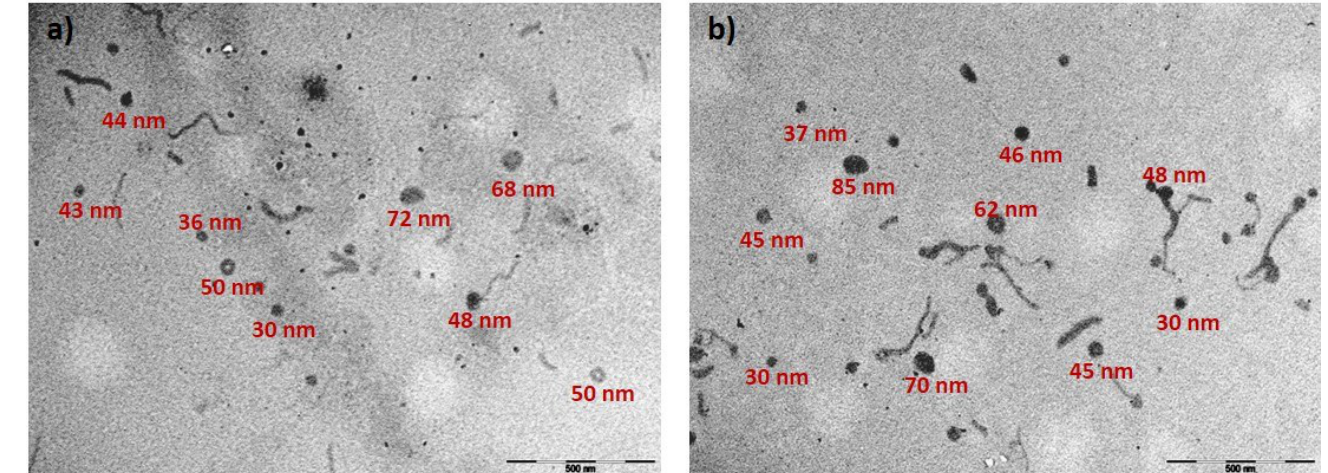
Figure 6. TEM images showing morphologies of polyplexes formed with ( a ) F68PEI and ( b ) F68PEI/F68 1:5 at N/P 50. The bar represents 500